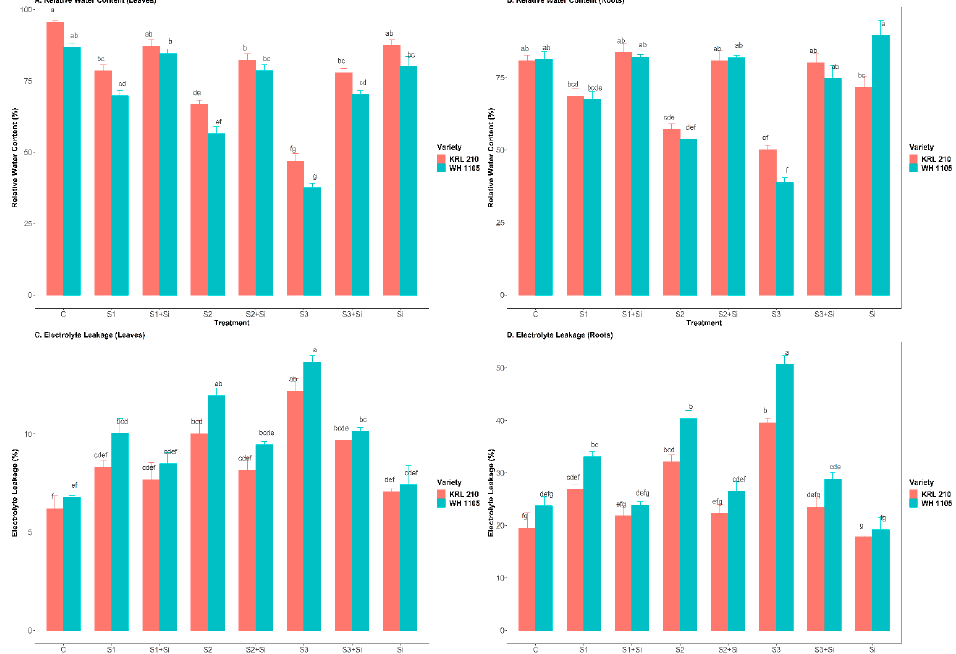
Figure 1. Effect of Si on relative water content (RWC) of leaves ( A ), RWC of roots ( B ), electrolyte leakage of leaves ( C ), and electrolyte leakage of roots ( D ) in salt-stressed wheat plants. Means ± SE; Two-way ANOVA with Tukey’s post hoc test; Each bar having different alphabets was significantly different between treatments ( p < 0.05). C: Control, S1: 40 mM NaCl stress, S2: 80 mM NaCl stress, S3: 120 mM NaCl stress, Si: 2 mM Silicon.